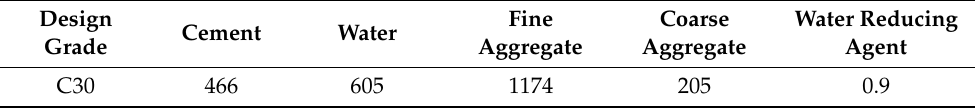
Table 3. Mix proportion of concrete per cube (units: